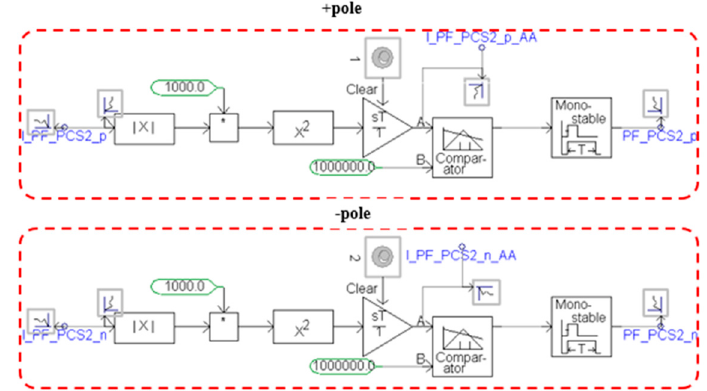
Figure 10. Modeling of DC power fuse.